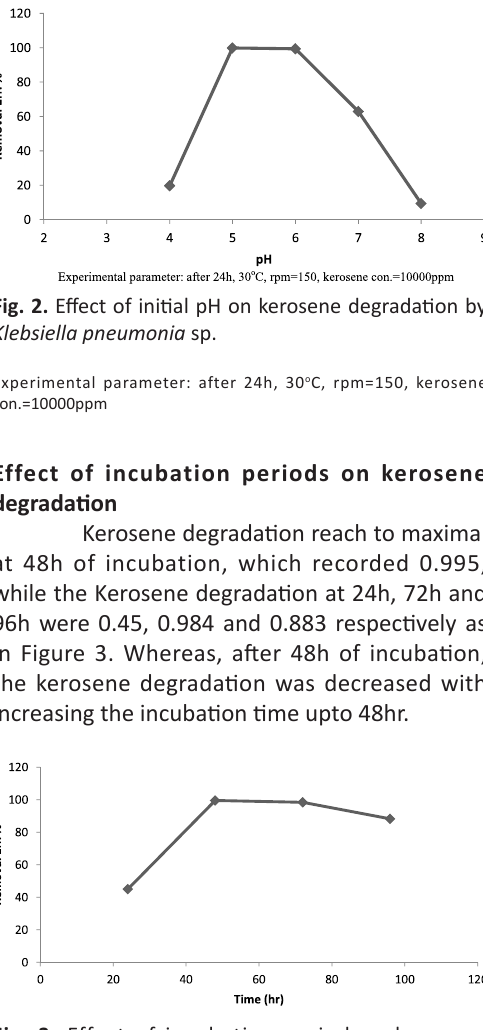
Fig. 3. Effect of incubation period on kerosene degradation from Klebsiella pneumonia